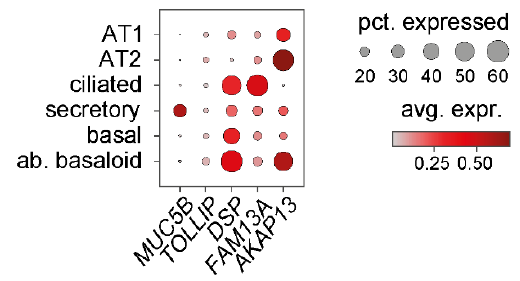
Figure 6. Expression of selected risk factor genes in epithelial cell populations. Using the data set described in Figure 3, expression of selected genes harbouring IPF risk-associated SNPs is given. Selection was based on previous reports on their expression in airway epithelium (see text for more details). pct., percentage; avg. expr., average expression; ab., aberrant.